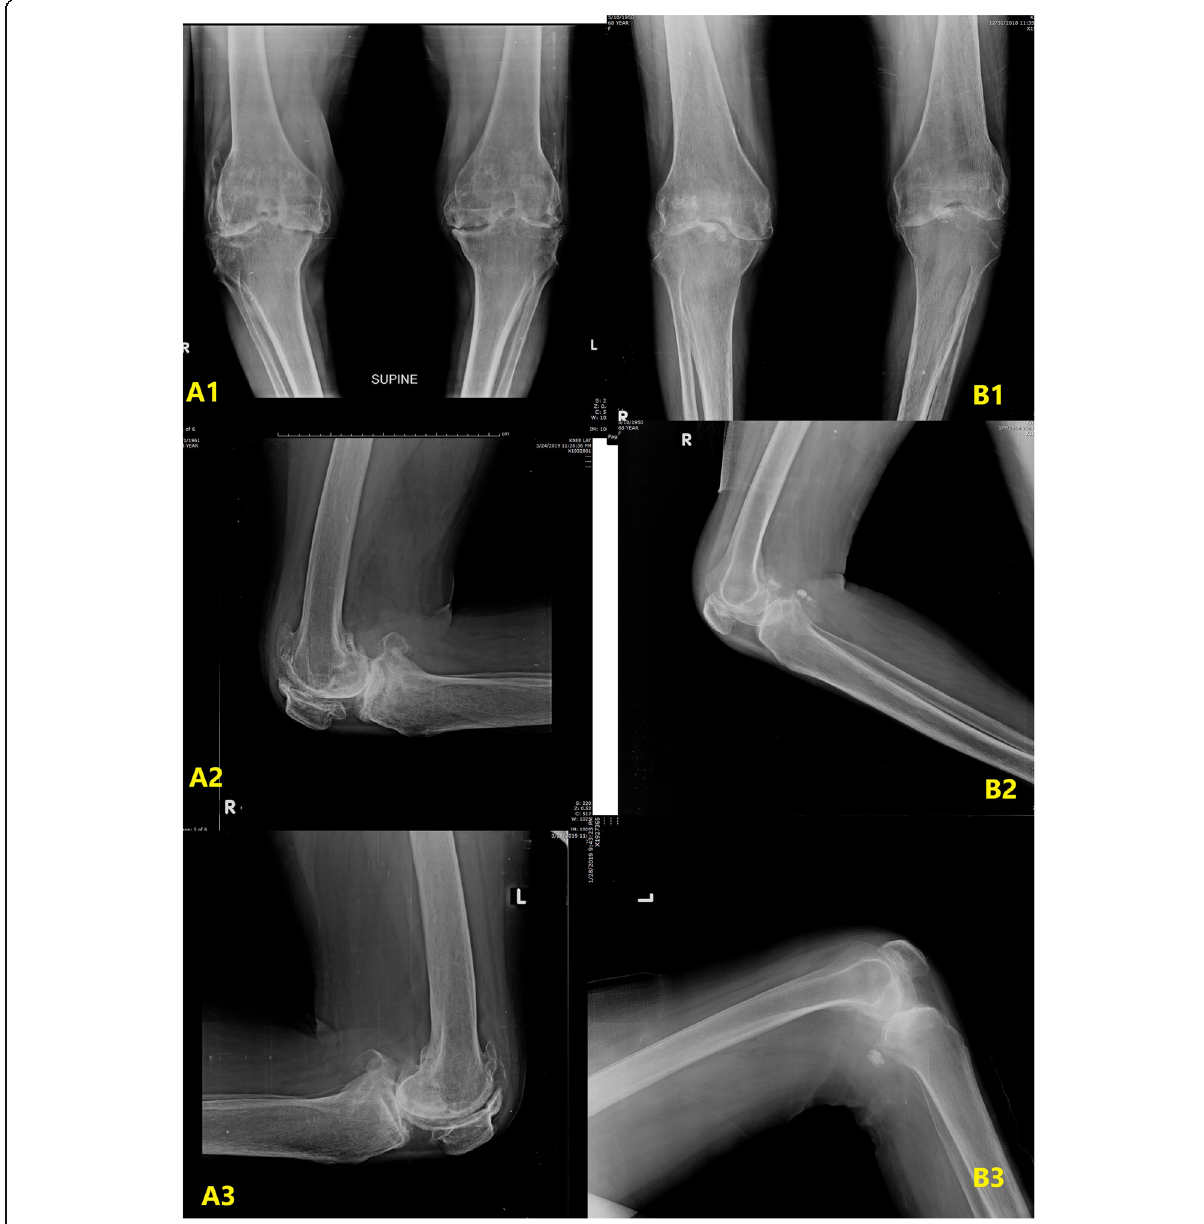
Fig. 1 A1 , A2 , A3 Flexion contracture deformity (FCD) in first patient. B1 – B3 FCD in second